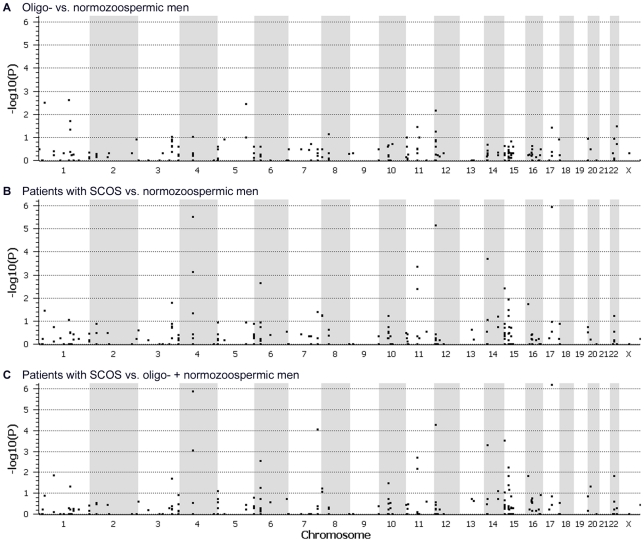
Plots of −log P-values of frequency comparisons for all recurring CNVs found in patients and controls grouped by chromosome.
P-values calculated by Fisher's exact test. The figure does not include the Y chromosome because no recurring variants were found on it.